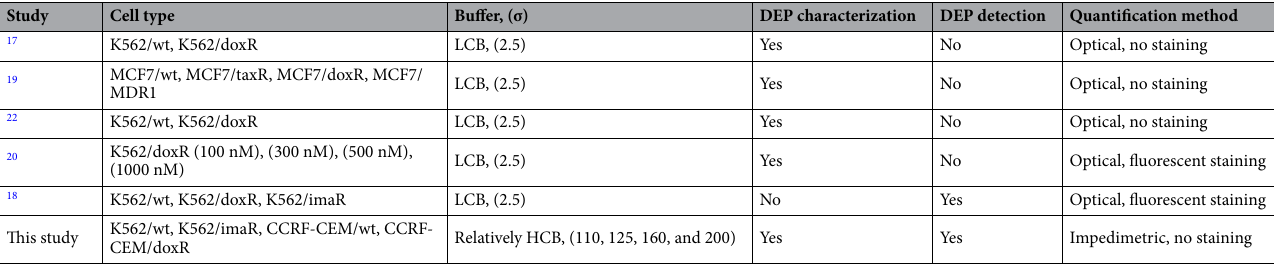
Table 1. Studies related to DEP-based analysis of MDR cancer cells in terms of cell type, DEP buffer conductivity, the aim of DEP usage (i.e. characterization of cell electrical properties or detection of MDR